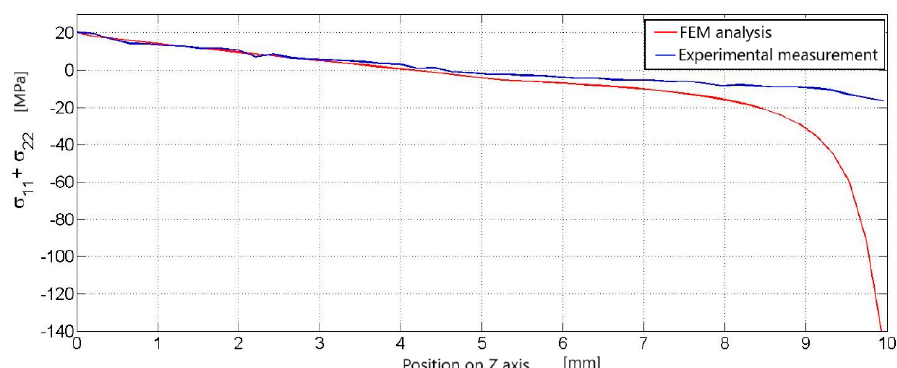
Figure 4. Comparison of the course of principal stresses in experimental measurements with the course of principal stresses in numerical analysis, waveforms according to the vertical black line (Figure 3), compared results for a load of 0.5 kN.